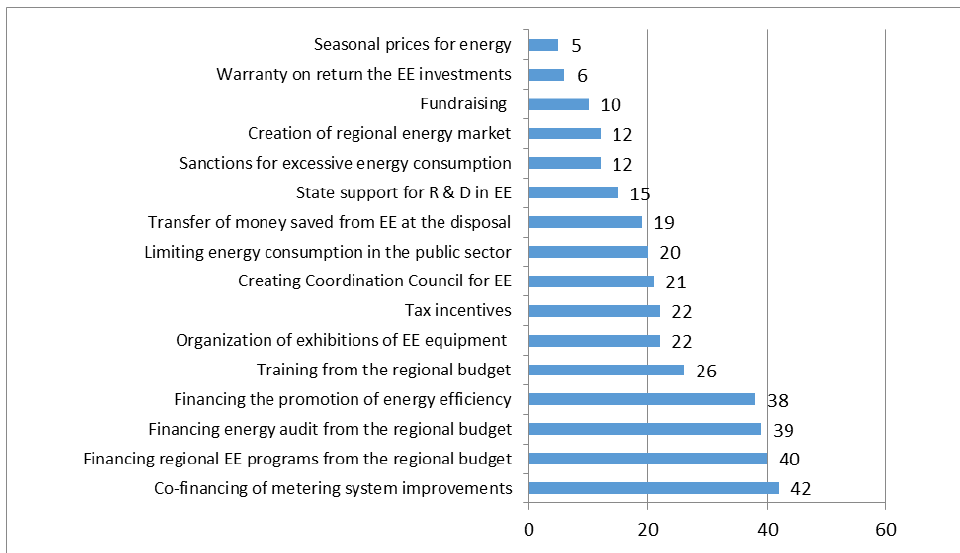
Figure 2: Instruments of implementation of regional policies on energy-efficiency in